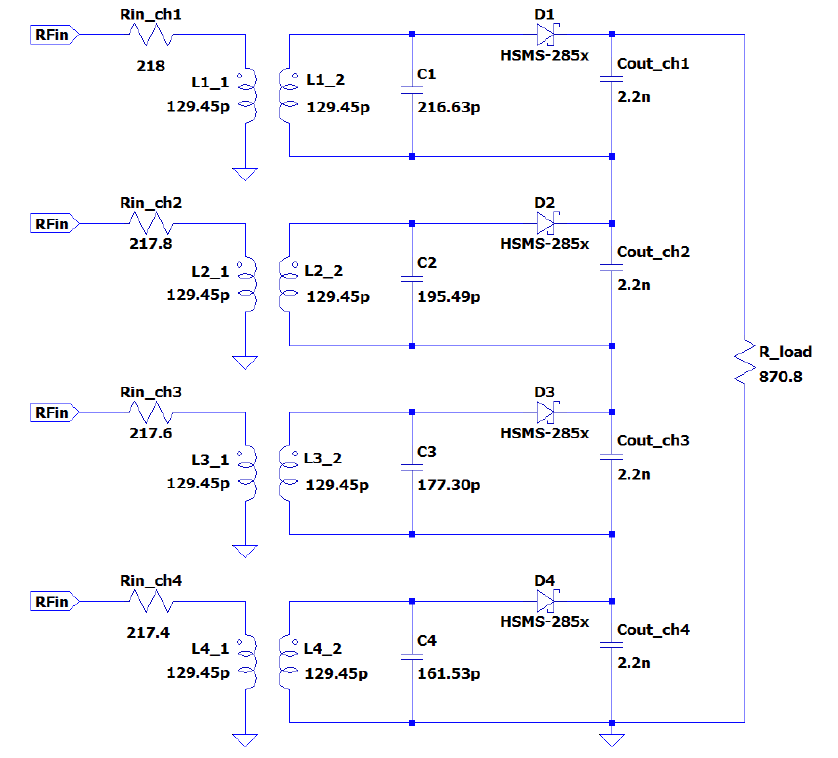
Figure 2. SPICE model of the proposed rectifier Rect _ A ; four channels are shown, whose operative frequencies are 950 MHz, 1000 MHz, 1050 MHz, and 1100 MHz, from top to bottom, respectively (values of components are also